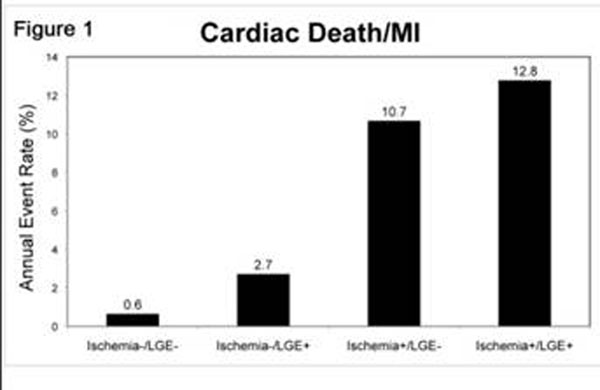
Cardiac Death/MI